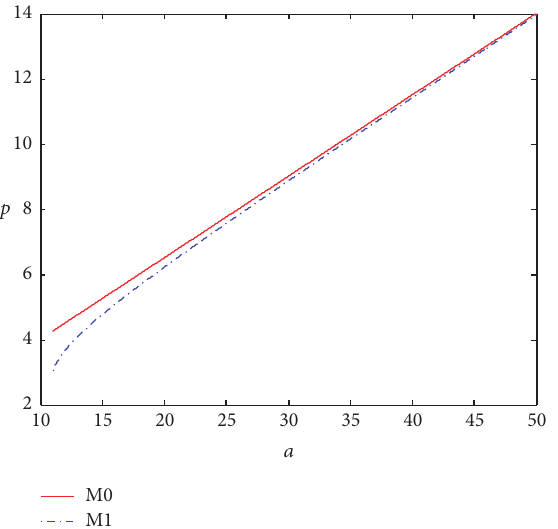
Figure 3: Optimal price comparison in models M0 and M1.